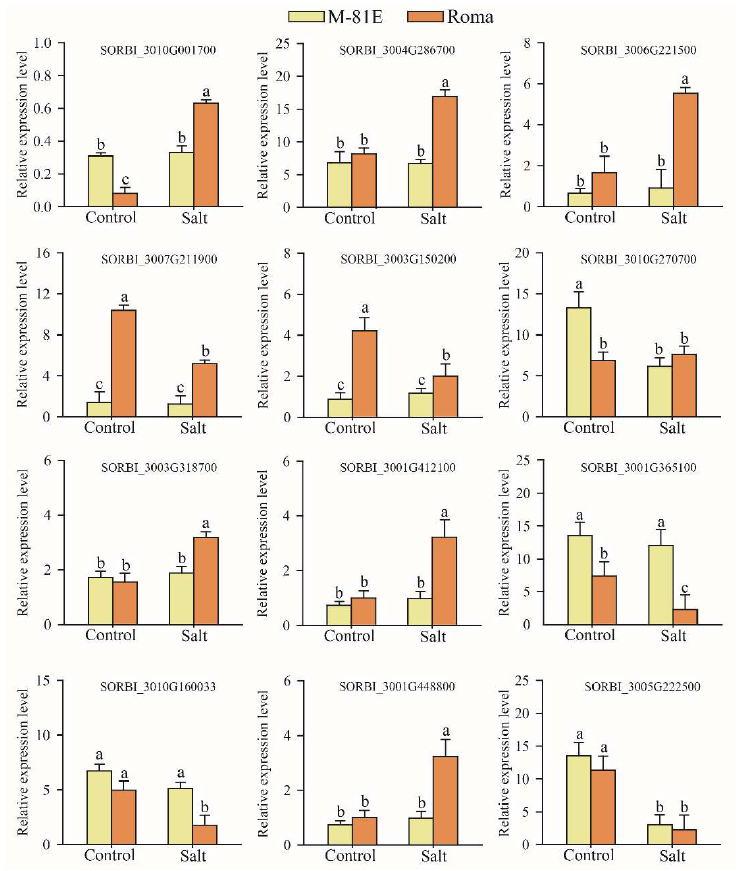
Figure 6. Verification of expression patterns of selected genes.